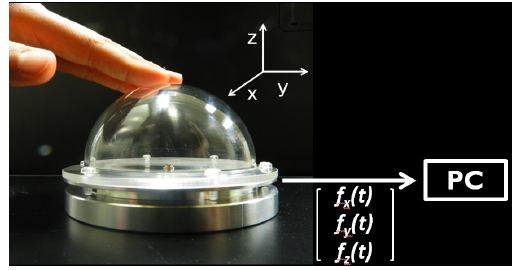
Fig. 5. Block diagram of the force data collection